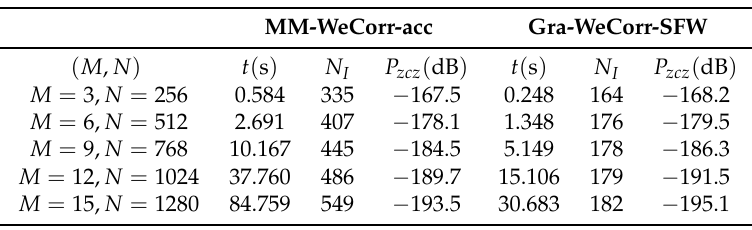
Gra-WeCorr-SFW ( ε = 10 − 10 ) .